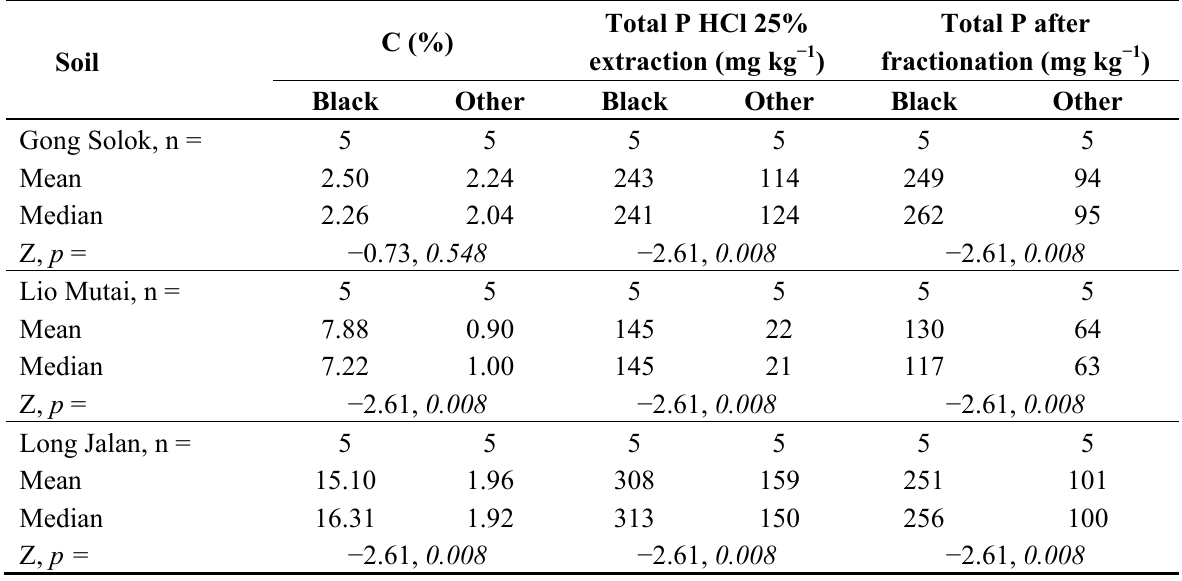
Table 3. Percentage soil carbon and phosphorus from five replicates within and just outside three occurrences of fertile black soil, Mann-Whitney test statistic (Z) and one-sided p values.